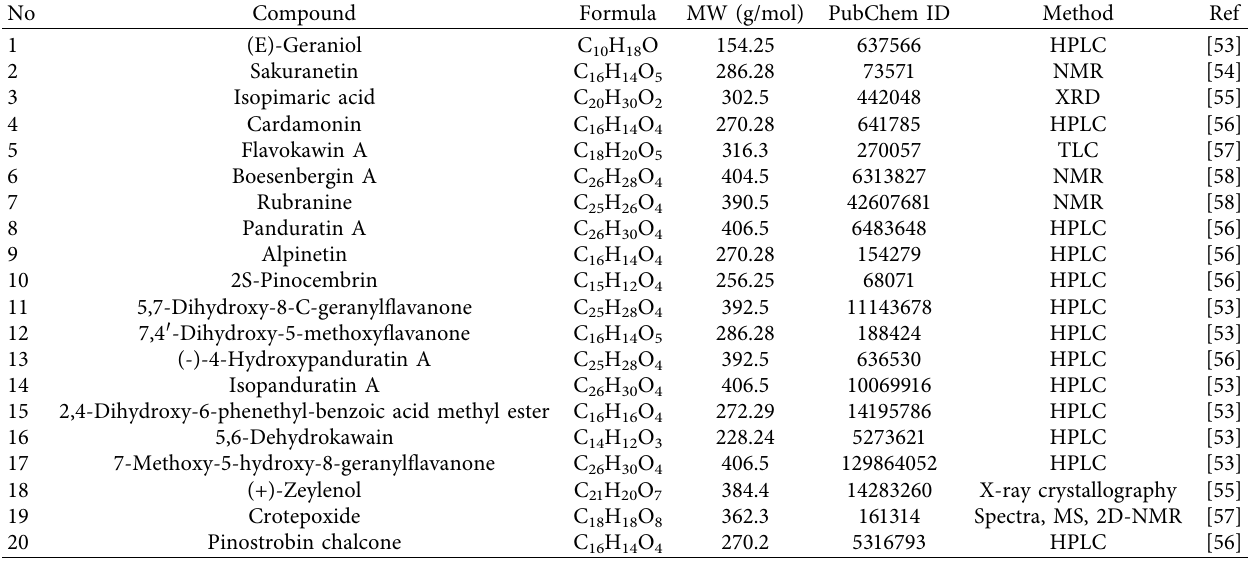
Table 1: Bioactive compounds in B. rotunda from the KNApSAcK database and the previous study.